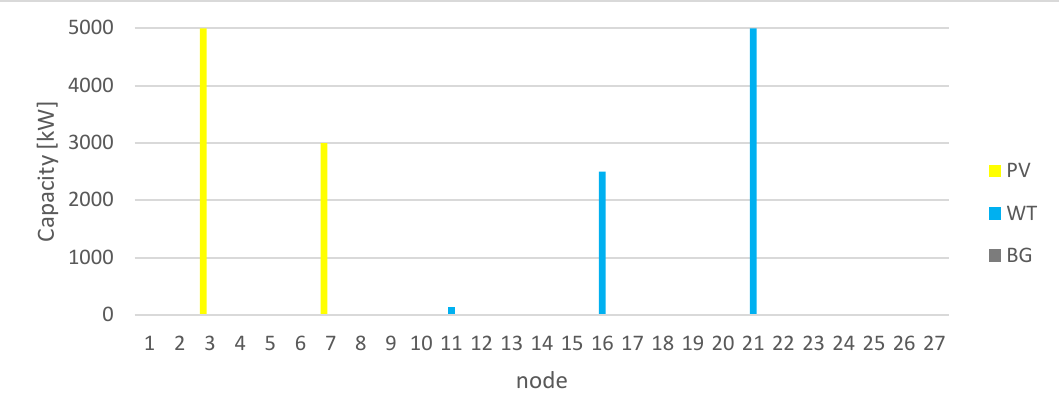
Figure A2. Capacity structure for scenario “1”.